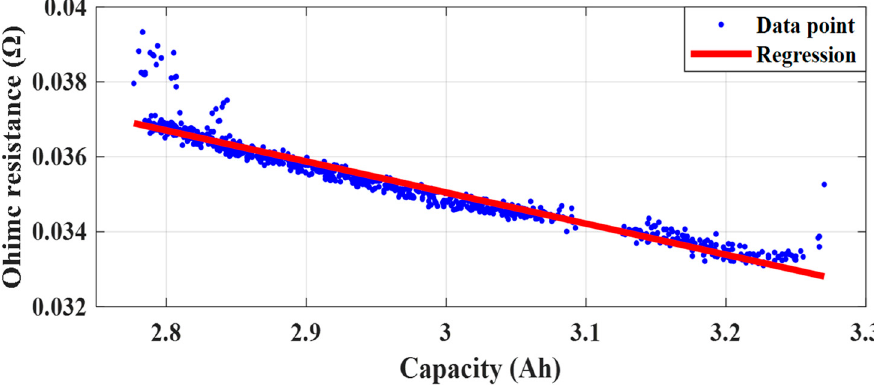
Figure 8. Linear fitting and residual analysis of the capacity and ohmic resistance.